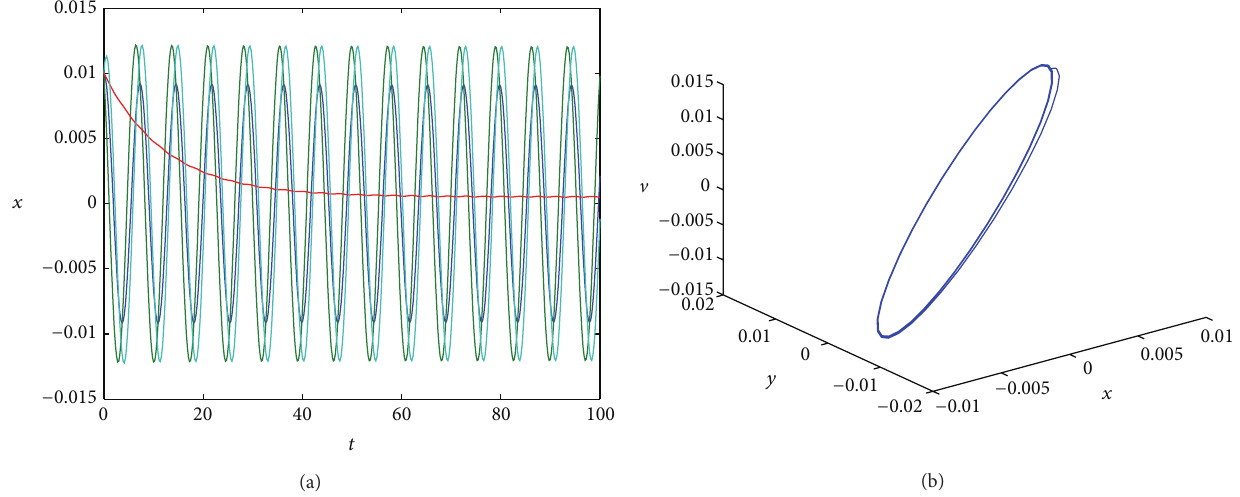
Figure 7: Time history and phase diagram of system (16) with 𝑎 = 1 , 𝑐 = 0.08 , 𝑚 = 0.5 , 𝑘 1 = 0.8 , 𝑘 2 = 0.5 , and 𝑏 = −0.15 .